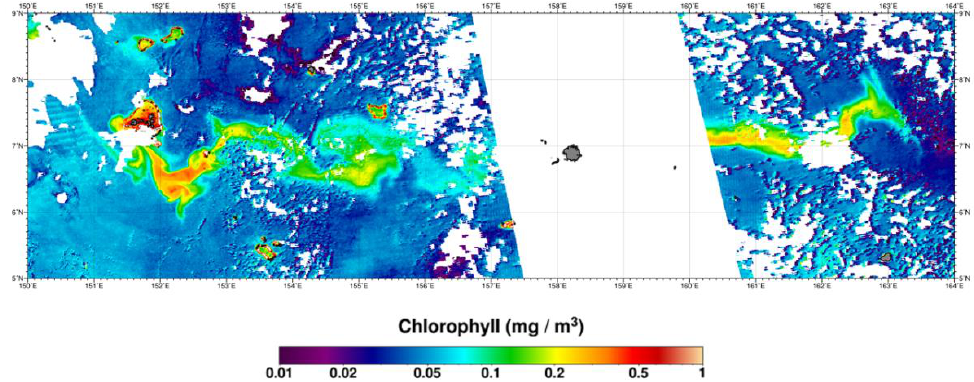
Figure 1. MODIS-Aqua false color image of Chuuk Lagoon and the oceanic region to the east, which was acquired on 12 October 2013. The island of Pohnpei was located in the MODIS instrument scanning swath gap on 12 October. The highest chl a (0.4–0.5 mg/m 3 ) is located southeast of Chuuk Lagoon, and a plume of elevated chl a is observed extending eastward from both Chuuk Lagoon and past Pohnpei. The boundaries of the region shown are 150–164 ◦ E, 5–9 ◦ N.